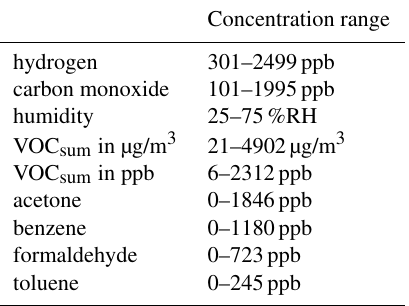
Table 2. Resulting concentration ranges by the generation of ran- domized gas